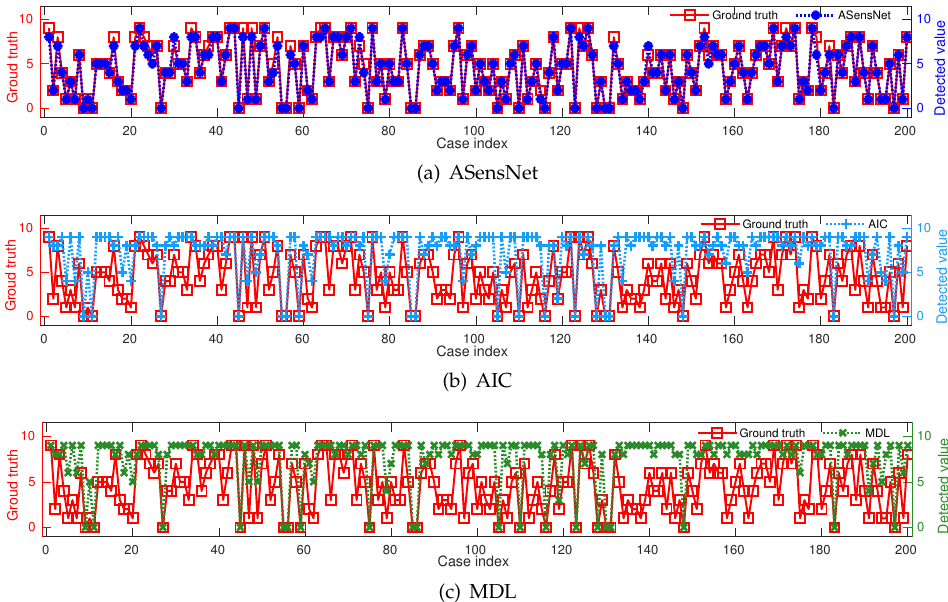
Figure 8. Case diagram like a real-time scenario.